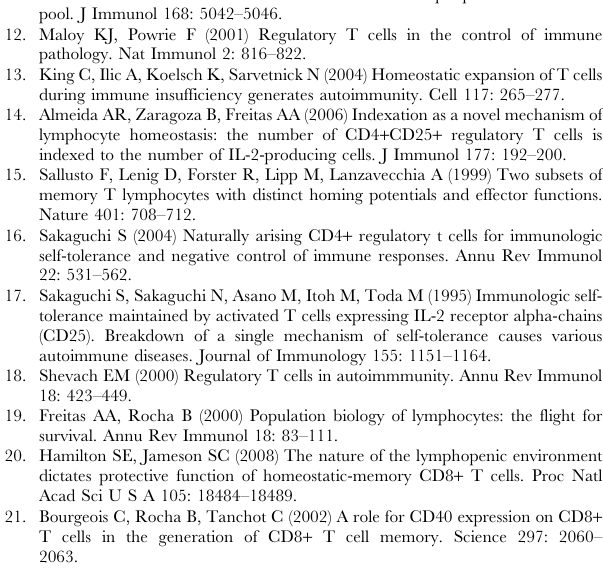
Figure S6 Phenotype of CD8 + T cells. Dot plots show the phenotype of donor CD8 + T cells from WT (left); INFR1 2 / 2 (middle) and IL-6 2 / 2 mice. Figure S7 Role of IL-2 in CD4 + T cell help. The fold increases of CD8 + T cell recovery 8 weeks after the transfer of 2 6 10 4 CD8 + T cells alone or with 2 6 10 4 CD4 + T cells into CD3 e 2 / 2 mice, calculated by dividing the number of CD8 + T cells recovered in the presence of CD4 + T cells by the number of CD8 + T cells recovered in the absence of CD4 + T cells. CD8 + T cell recovery increased 10 to 30-fold in the presence of WT CD4 + T cells, but only 2 to 3-fold in the total absence of IL-2 or if they lacked the IL-2R b